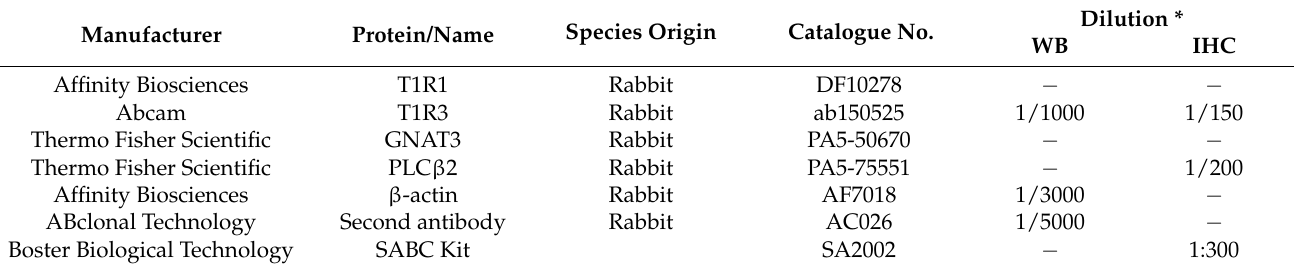
Table 2. Antibodies were applied in immunohistochemistry (IHC) and Western blotting (WB).